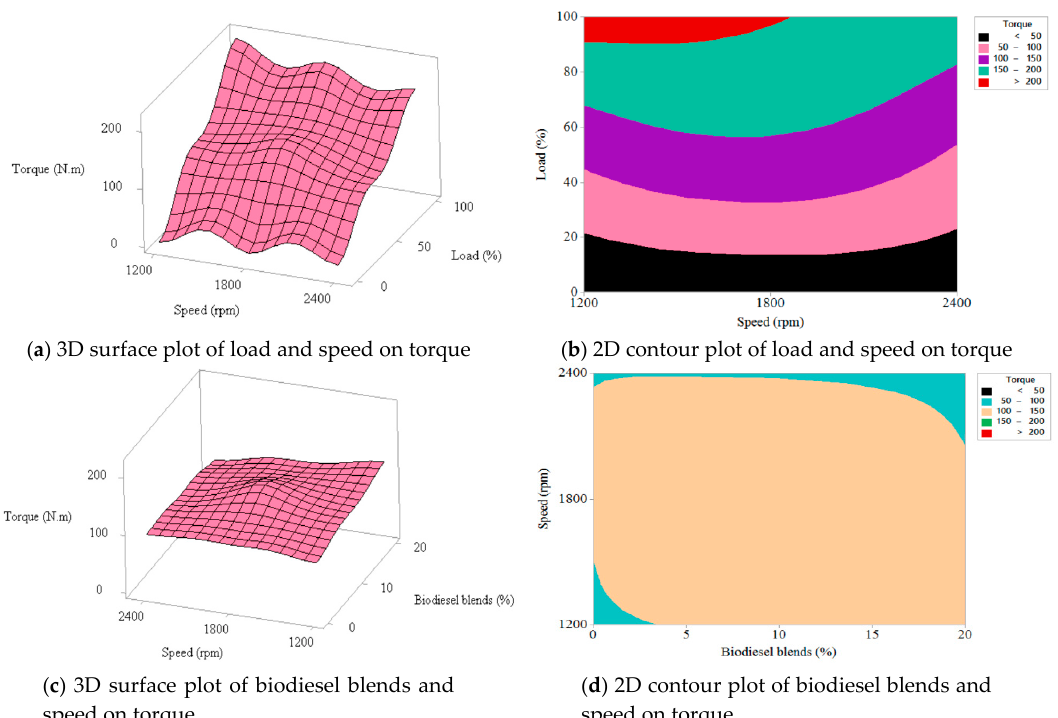
Figure 7. Combined effects of biodiesel blends, load, and speed on torque (Nm).